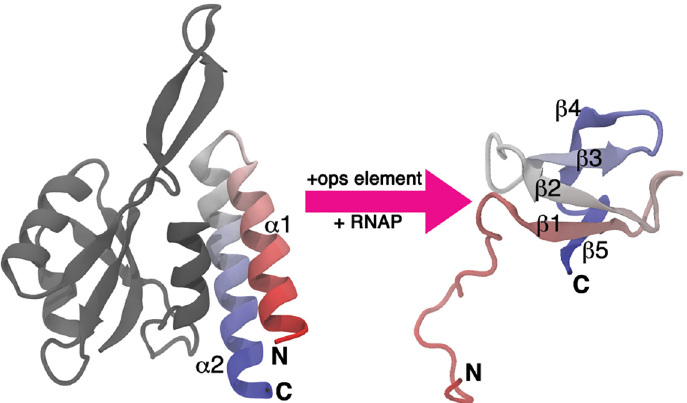
Fig 1. Structural transformation of the RfaH CTD. Domain dissociation is triggered upon binding of the NTD (gray) to its target ops ( operon polarity suppressor ) element DNA, relieving the autoinhibited state and allowing the transformation of the CTD (colored) from an α -helical hairpin (left) towards a five-stranded β - barrel (right). Note that the NTD and CTD are connected by a linker that does not order within the crystals and therefore is not shown in the figure. The accession codes for the structure of full RfaH in the α fold and of the excised CTD in the β fold are 2OUG and 2LCL, respectively.